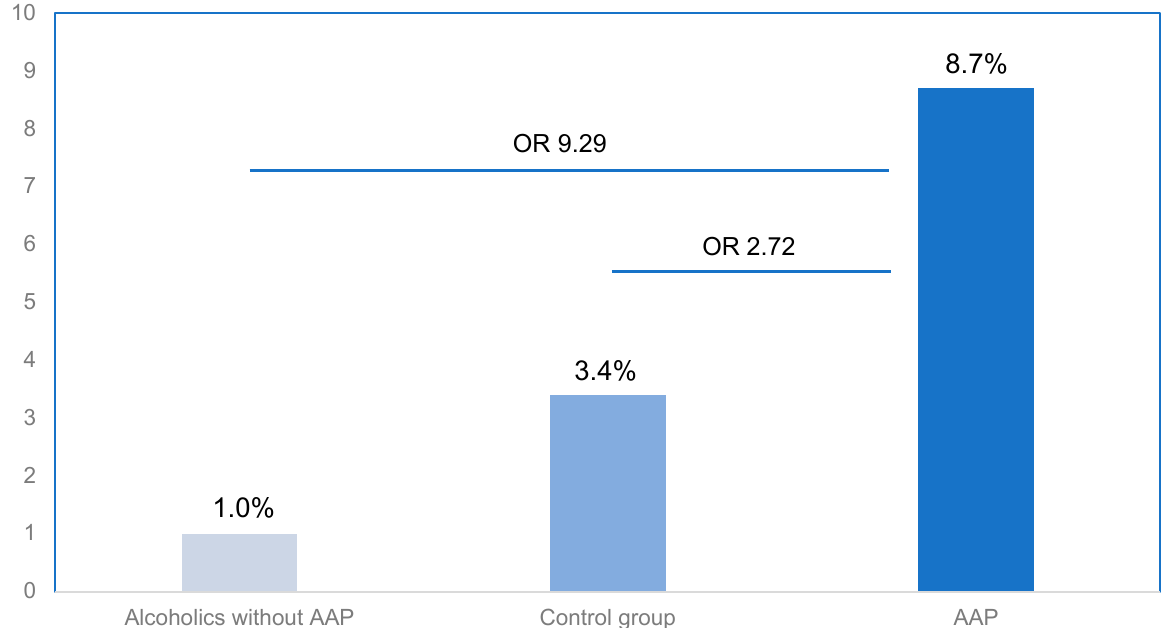
Figure 1. The prevalence and odds rations of SPINK1 (N34S) in patient and control groups. In a binomial logistic analysis comparing AAP patients with the control population adjusted for smoking, alcohol consumption, BMI, gender and T2DM (Table 2), the SPINK1 mutation did not remain as an independent marker in AAP (OR 2.36; 0.40–14.02). In this model, alcohol consumption (daily intake g/day: OR 2.11; 1.85–2.40), male sex (OR 3.08; 1.29–7.39) and smoking (OR 2.60; 1.29–5.22) were found to be independent markers in AAP. Other cofounders were not statistically significant. When using the same model comparing AAP patients and heavy alcohol users, SPINK1 was found to be an independent marker in AAP (OR 26.32; 2.52–274.41) and male sex (OR 12.96; 4.54–36.96). In this comparison model, amount of alcohol consumed was found to have a negative correlation (OR 0.83; 0.78–0.88). Table 2. Known risk factors for AAP in a binomial regression analysis comparing AAP patients with alcoholics and healthy controls.